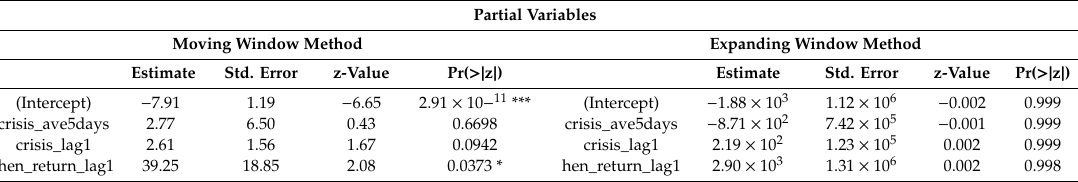
Table A1. Estimated LogR model result: Partial variables.